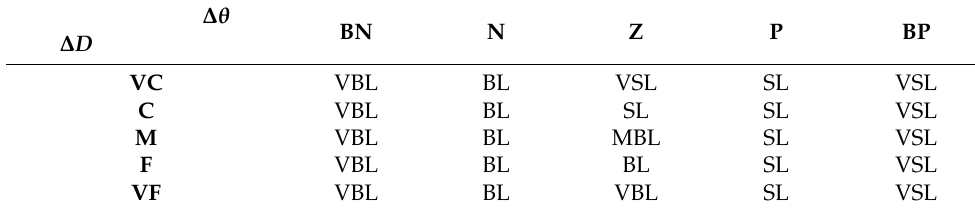
Table 4. The rules of the left wheel angular